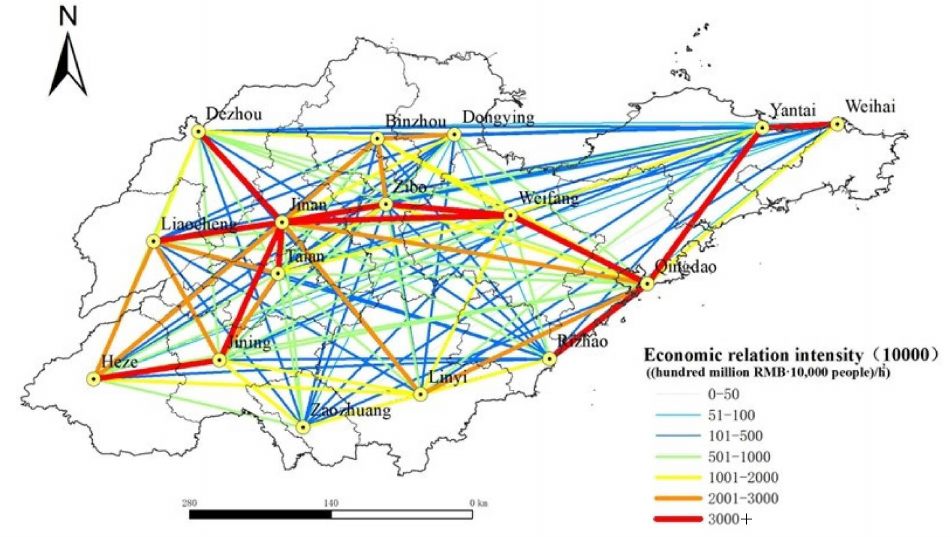
Figure 8. Prediction of urban economic relation intensity in Shandong Province, China, in